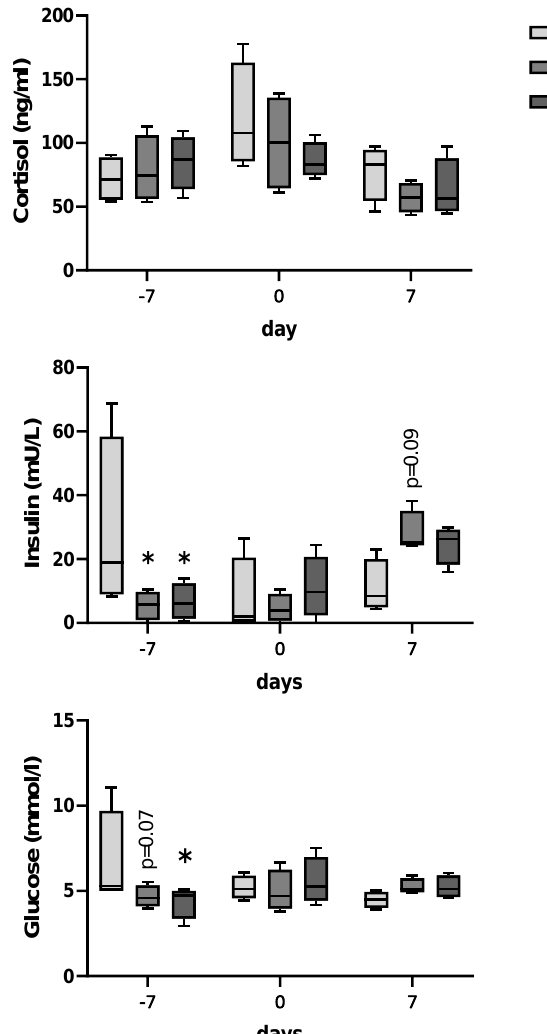
Figure 2. Cortisol, insulin and glucose levels in sows’ plasma one week before farrowing (−7 d), on the farrowing day (0 d), and one week after farrowing (7 d). Sows received either a basal diet (NC), or supplementation with isoquinoline alkaloids (IQ) during gestation and lactation (IQ1), or only during the lactation period (IQ2). Data presented in boxplot: box line + median, mean ± bars (inner fences defined by Tukey’s method). Statistical differences were considered when p < 0.05, as indicated by asterisks (*, p < 0.05); statistical trends were considered when 0.1 > p > 0.05.